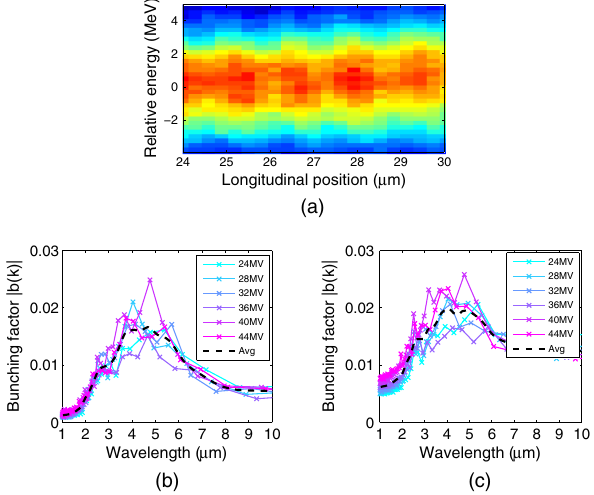
FIG. 13. (a) Electron beam image at 4.3 GeV and XTCAV voltage set to 44 MV showing camera pixel resolution of approximately 0 . 25 μ m. (b) Standard bunching factor vs XTCAV voltage shows no evidence of resolution limits. (c) The modified bunching factor shows slightly higher short wavelength bunching with higher XTCAV voltage, but this may be due to the higher noise threshold at that